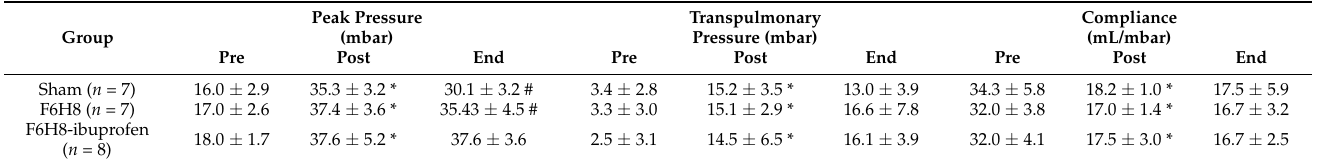
Transpulmonary Pressure (mbar)